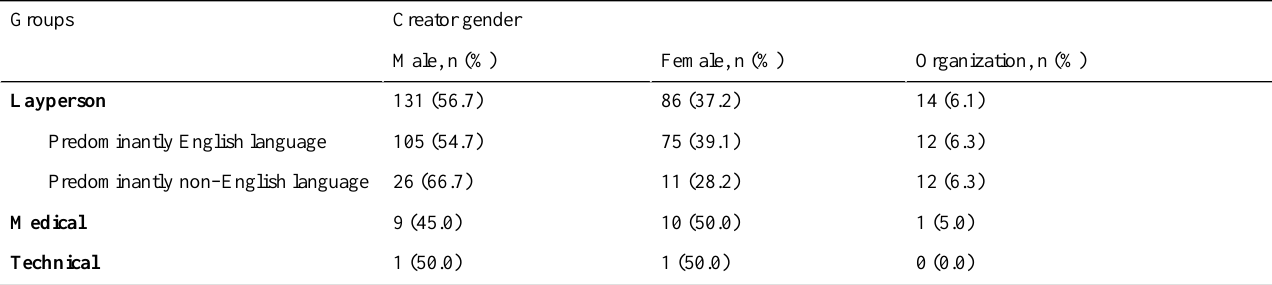
Table 4. Distribution of creator genders (male, female, or organization) among layperson, medical, and technical groups. Creator